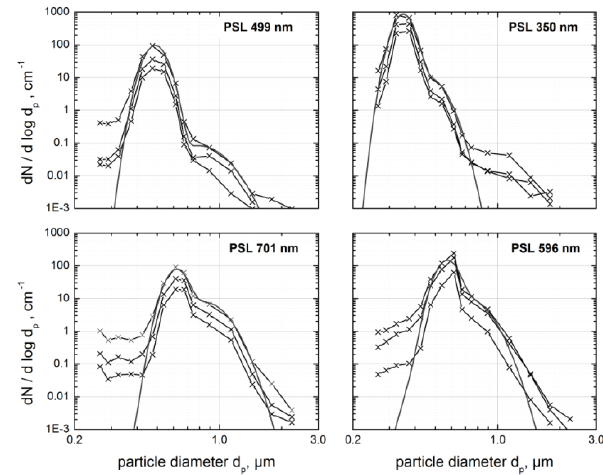
Fig. 4. Number size distributions of PSL spheres measured down- stream of the DMA; grey lines represent bimodal log-normal size distributions representing PSL and PSL conglomerates. Nominal sizes of atomized PSL standards are